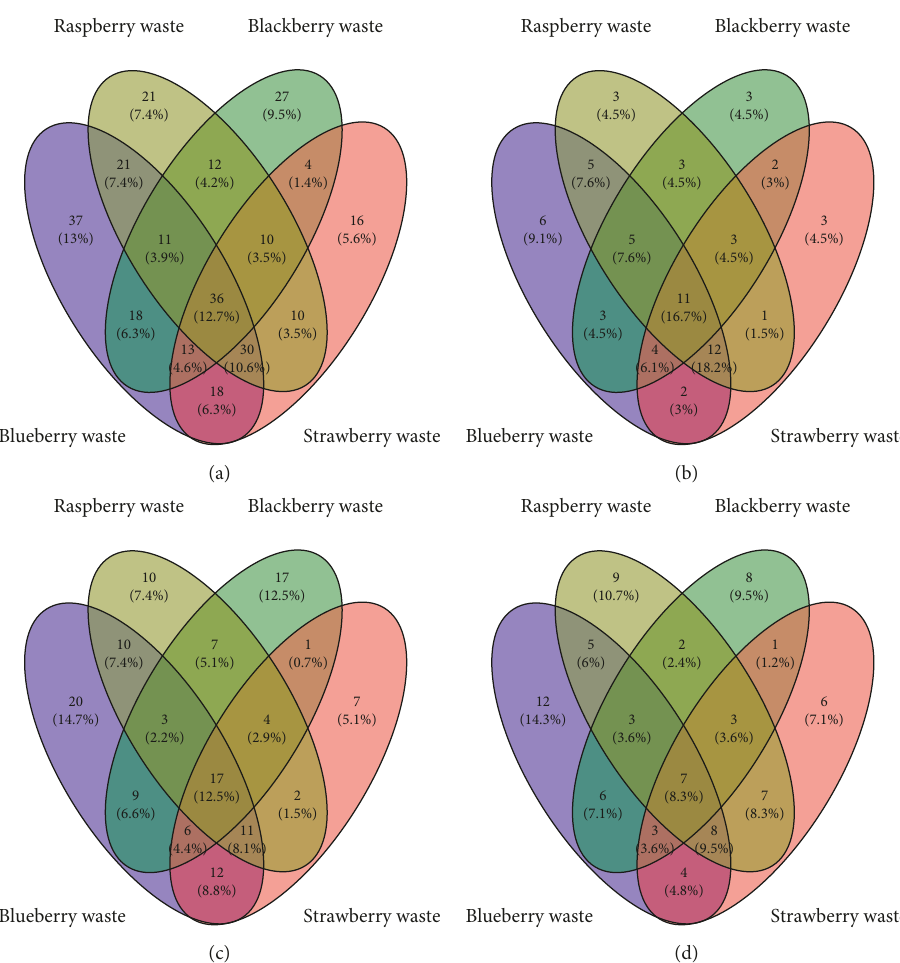
Figure 1: Venn diagram of phenolic compounds present in four waste berries. (a) shows the relations of total phenolic compounds among the four berry waste samples. (b) shows the relations of phenolic acids present in berry samples. (c) shows the relations of flavonoids among the berries. (d) shows the relations between other phenolic compounds in different waste berry